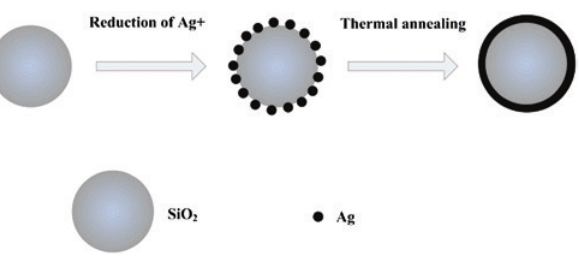
Figure 1: Schematic illustration of deposition procedure for synthe- sizing the SiO /Ag composite spheres. 2